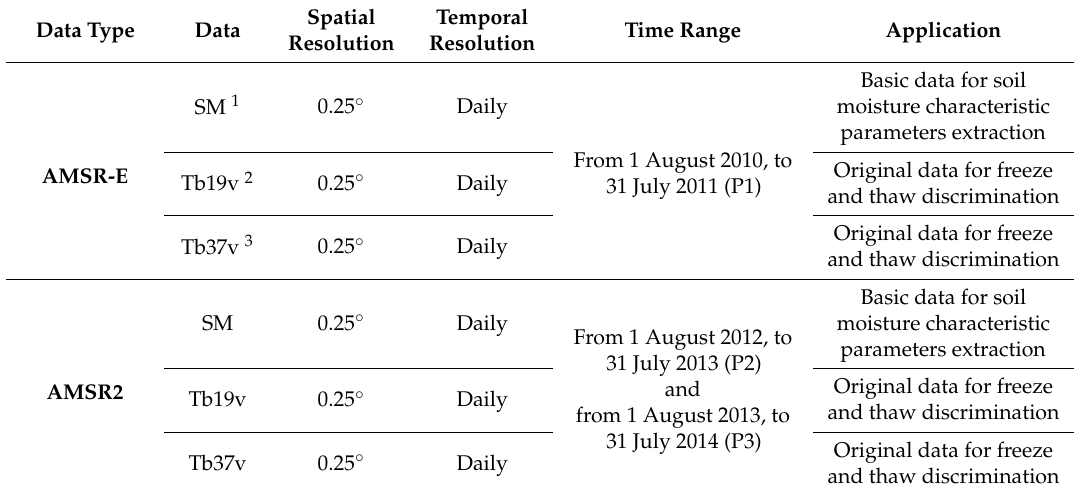
Table 1. The detailed specifications of the AMSR-E and AMSR2